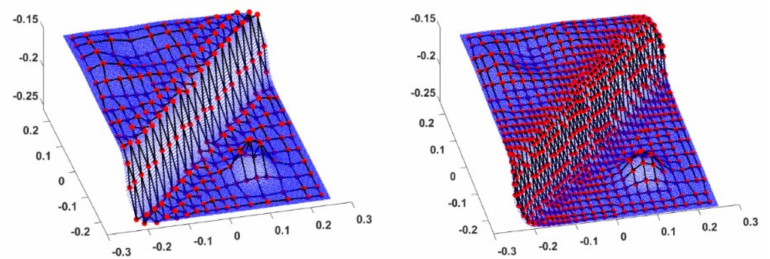
Figure 1. Illustration of the control T-mesh over a given parametrized surface. Red points are the control points, black the mesh